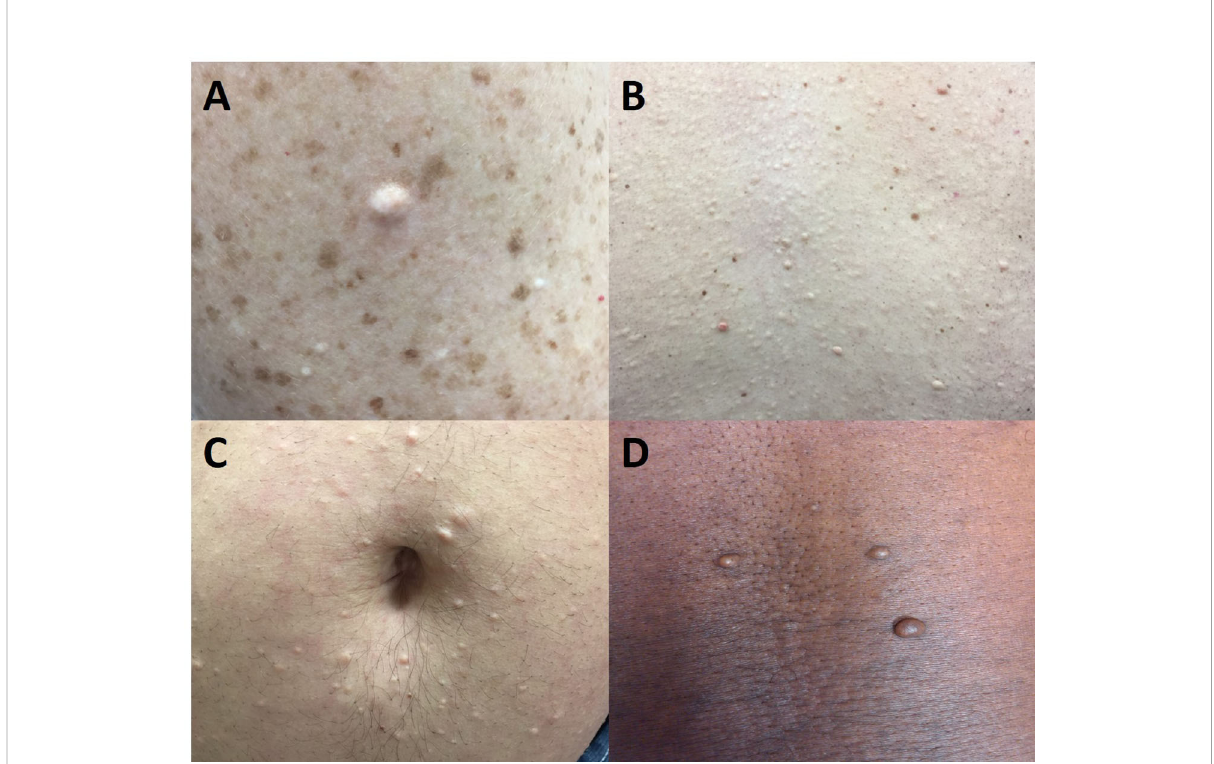
FIGURE 2 Multiple endocrine neoplasia type 1-associated collagenomas, which are benign connective tissue nevi with a dominant collagen component. They are hypopigmented or skin-colored and usually found on the neck, shoulder, and trunk. (A) 46-year-old woman with multiple collagenomas in addition to pigmented nevi on the arm. (B) 46-year-old man with innumerable collagenomas on the back. (C) 33-year-old man with multiple peri-umbilical collagenomas. (D) 46-year-old man with truncal